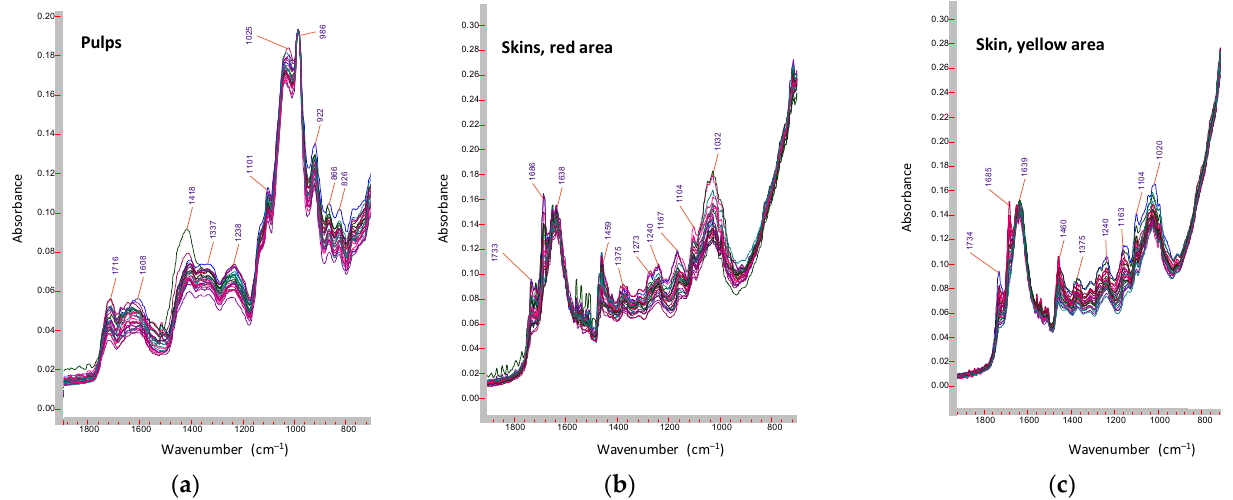
Figure 3. Superimposition for ATR-FT-MIR spectra relevant to lyophilized samples in the spectral region 1900–700 cm − 1 : ( a ) mesocarp (pulp), ( b ) skin, red area, and ( c ) skin, yellow area.